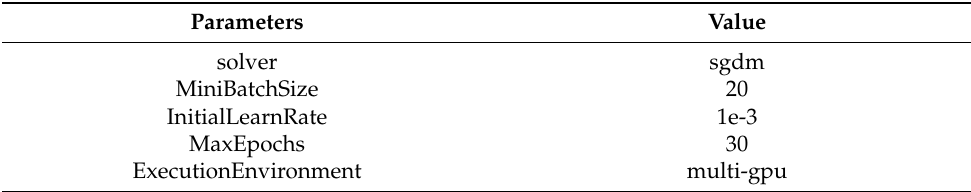
Table 6. Training parameters of the examined CNN models.